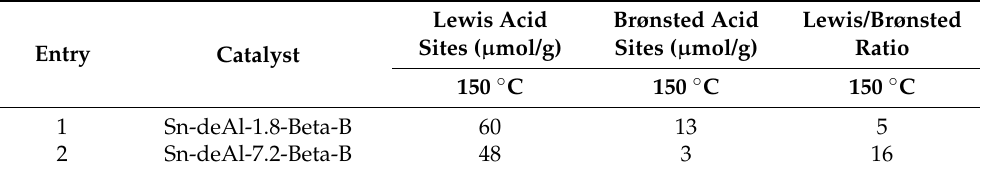
Table 3. Type and amount of surface acid sites in the Sn-Beta zeolite beads estimated by pyridine TPD-FT-IR.